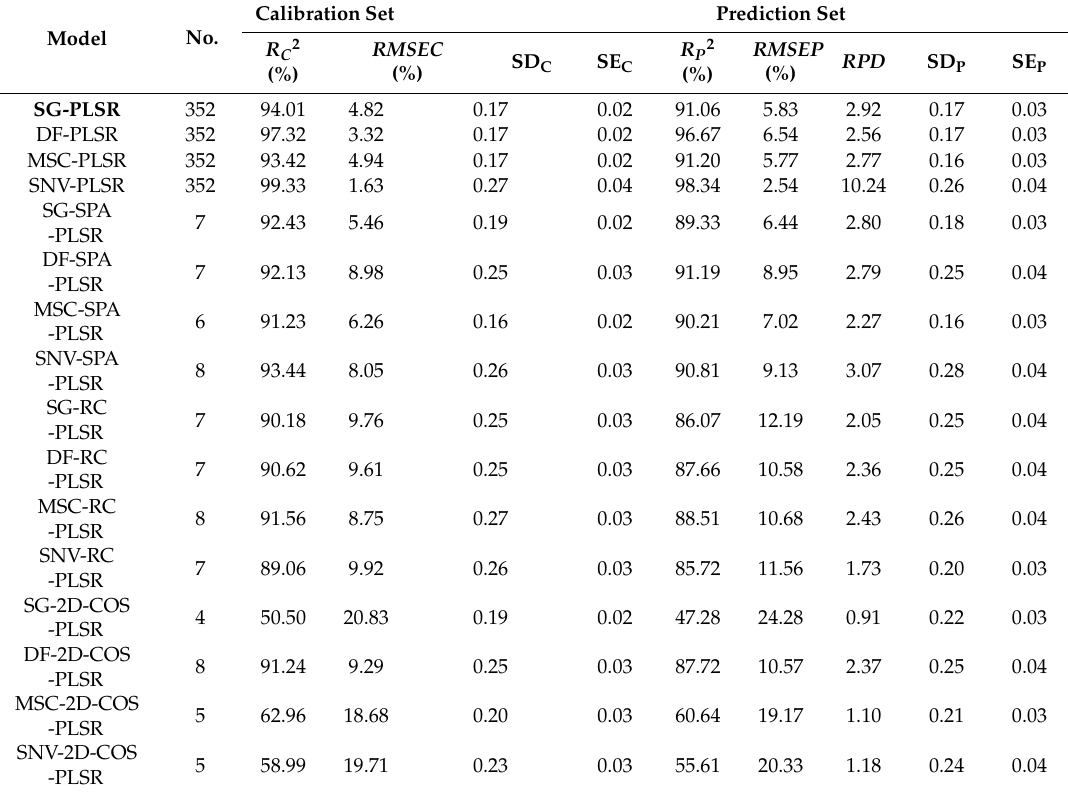
Table 6. Evaluating parameters of PLSR model of the belly